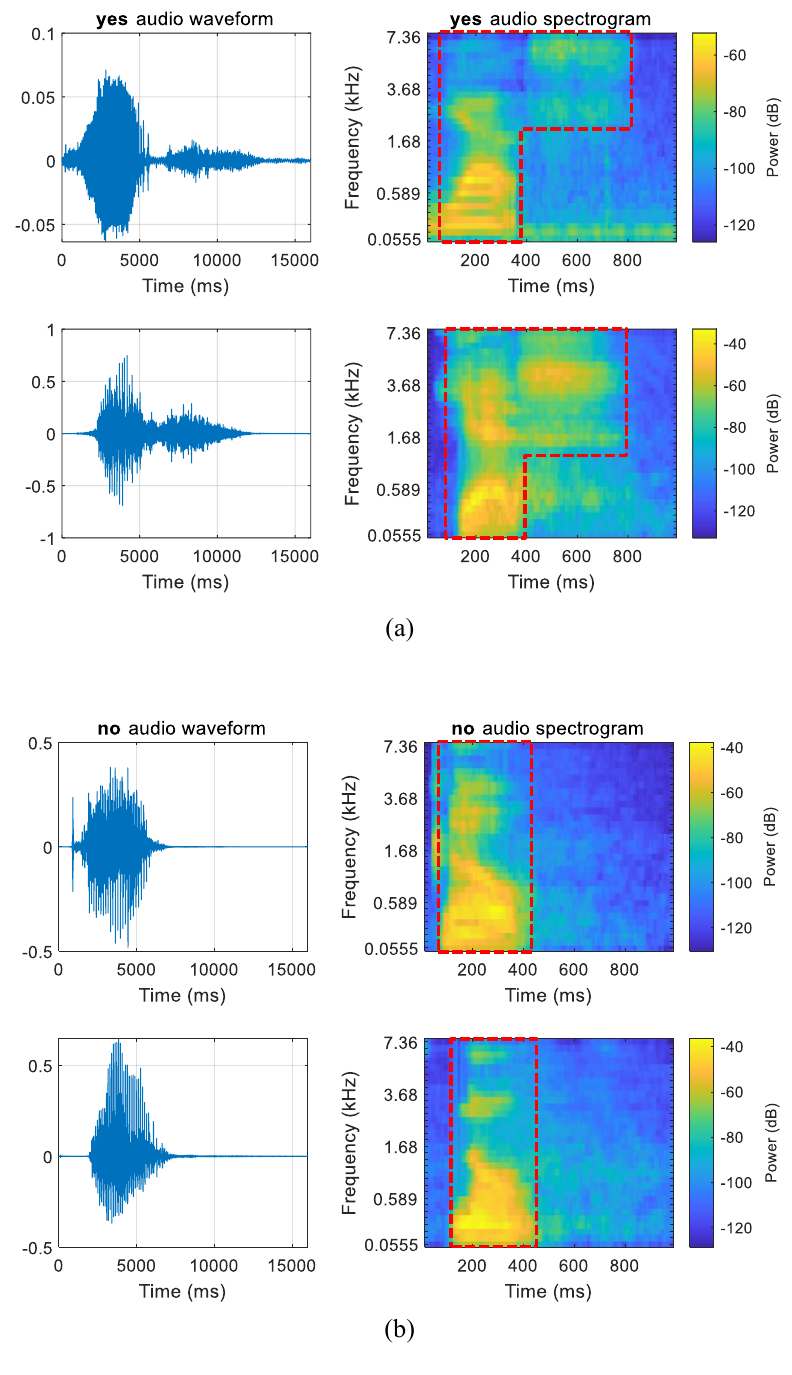
Figure 3. Audio waveform and spectrogram comparison according to words. ( a ) “yes” word waveform and spectrogram ( b ) “no” word waveform and